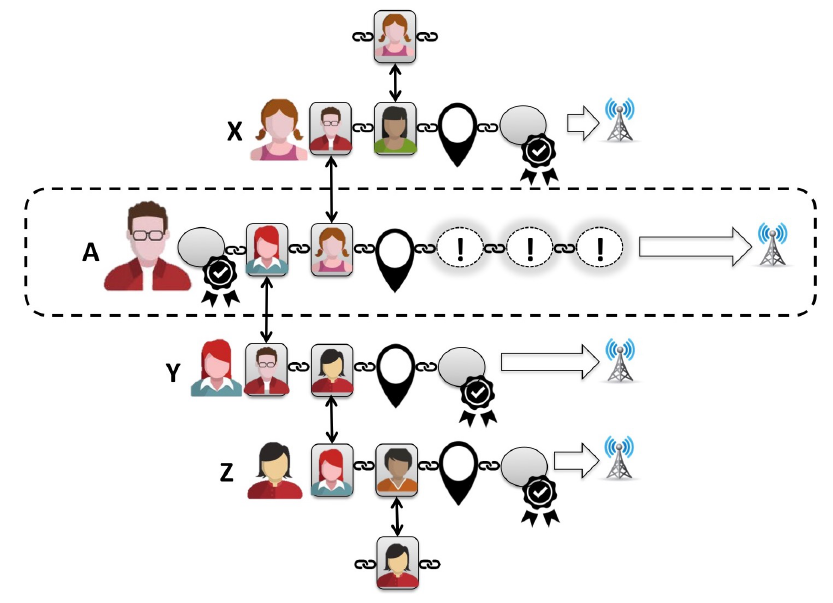
Figure 9. Extended diagram of behavioural